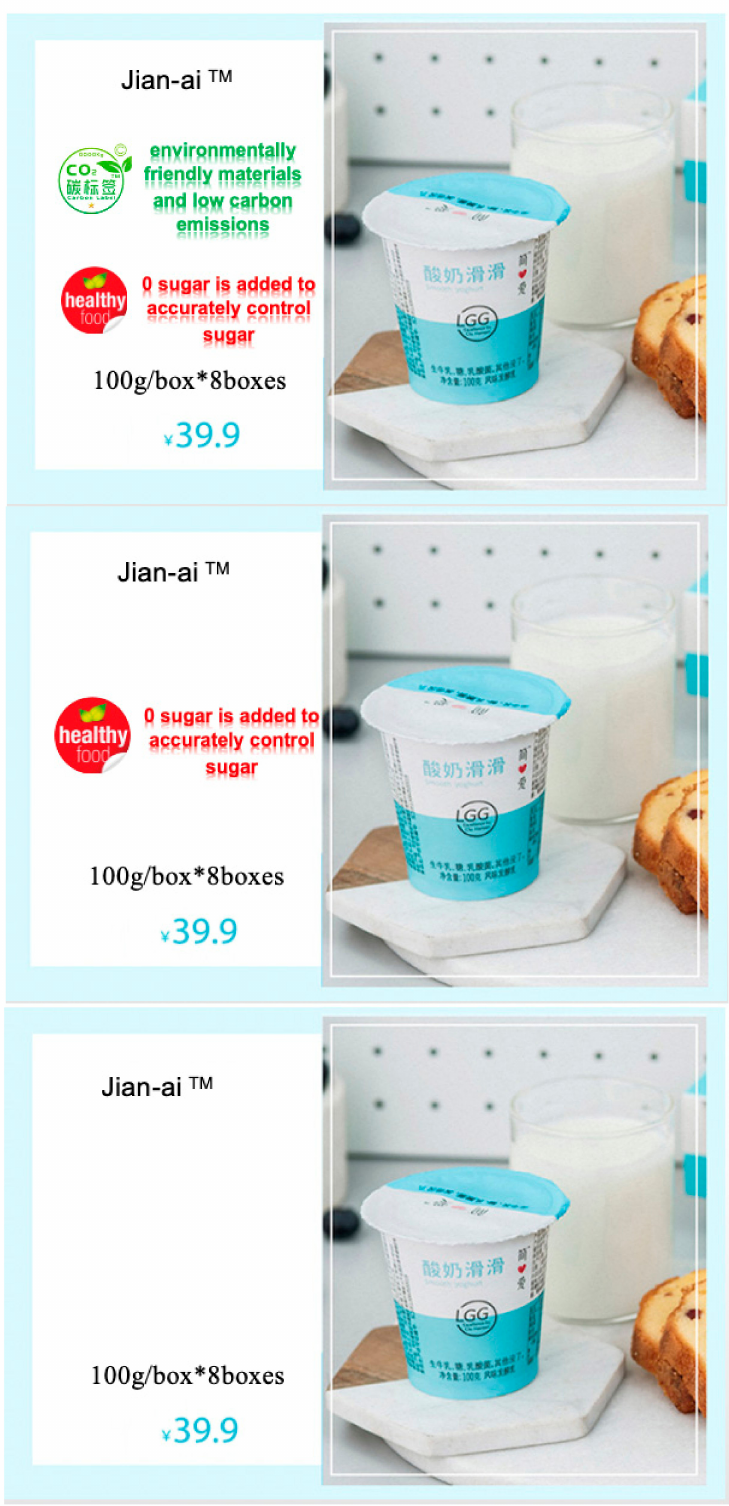
Figure 5. Labels in study